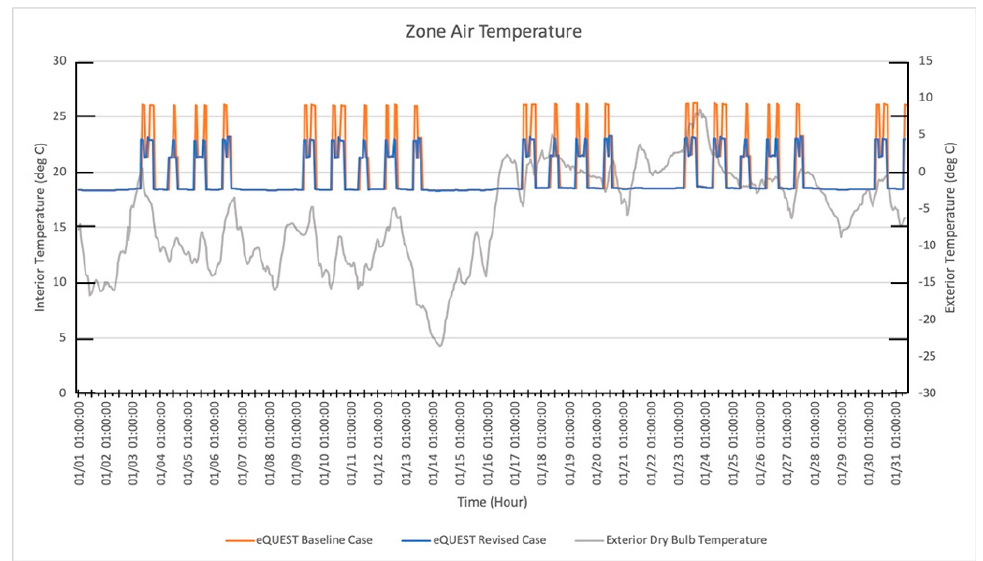
Figure 10. eQUEST temperature results in January with baseline case (red) and revised case 2 (blue), showing a reduction in indoor air temperature when outdoor air flow rate is increased.